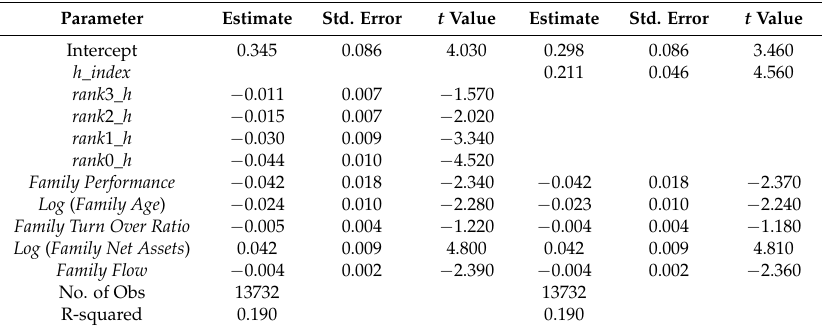
Table 7. Competition and family-level marketing expenses.